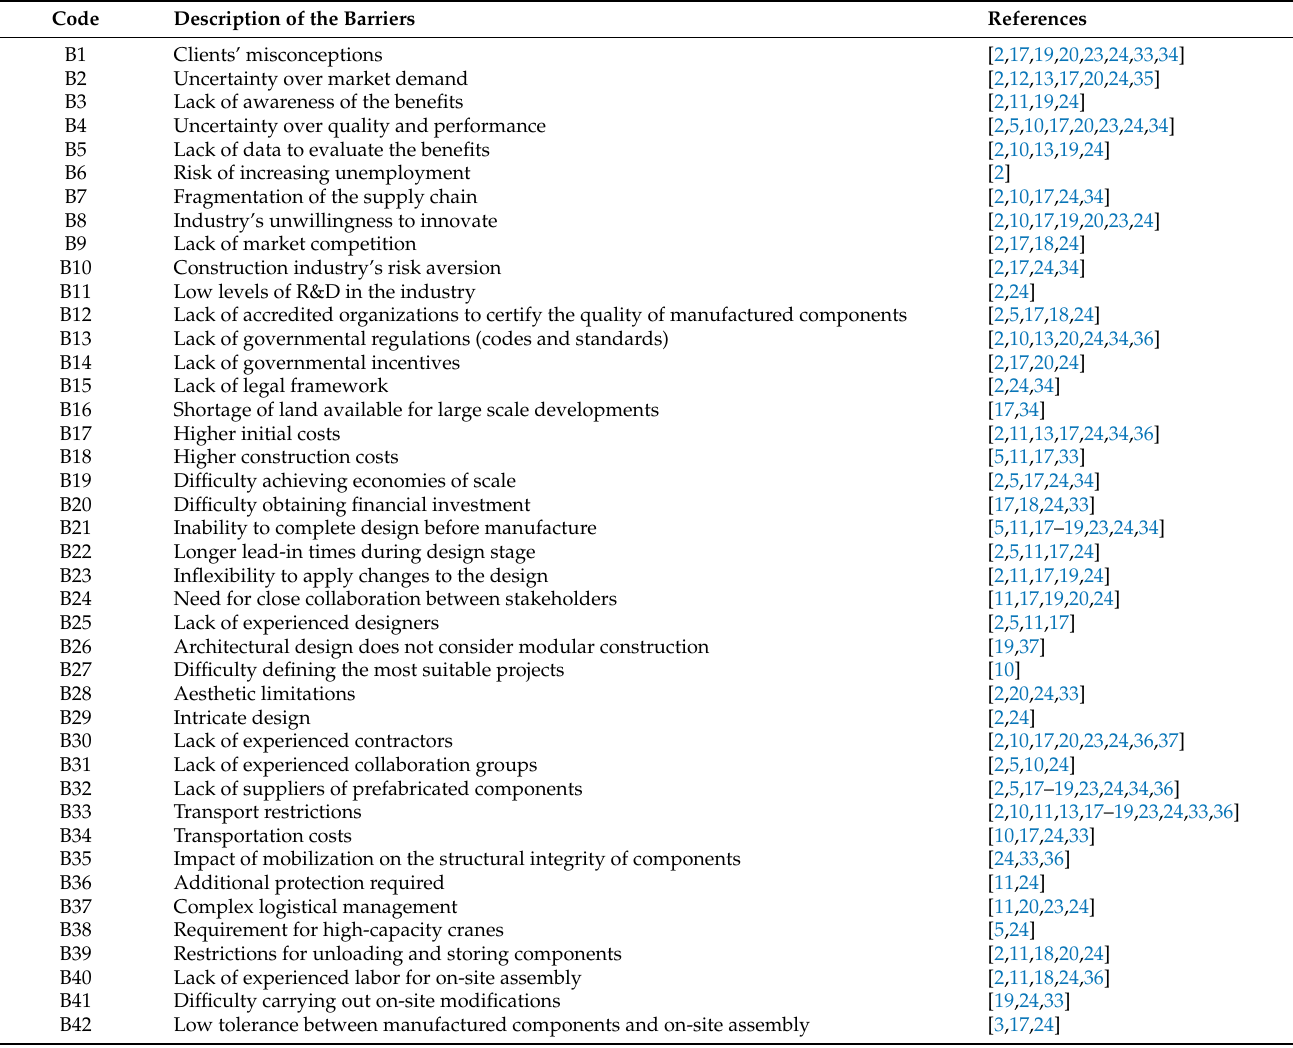
Table 1. List of barriers to the